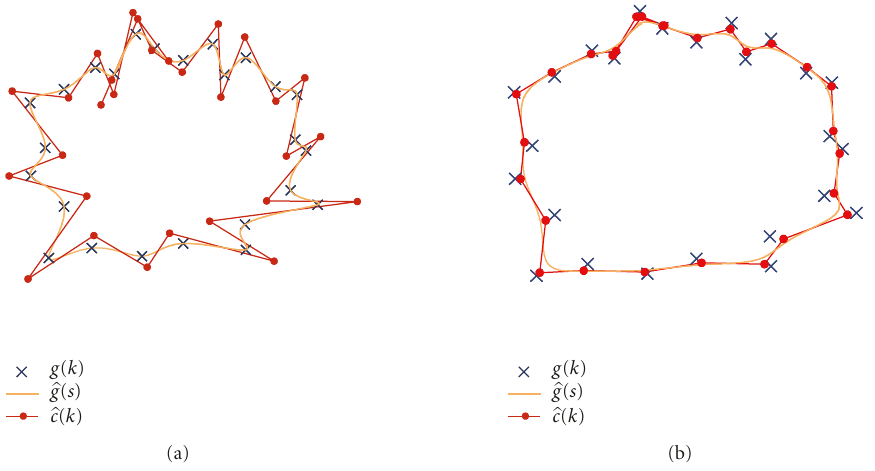
Figure 3: A smoothing B-spline curve. The points to approximate are the g ( k ) represented by the cross symbols. The (cid:9) c ( k ) are the coe ffi cients of the smoothing B-spline and are represented by the dot symbols. The curve (cid:9) g ( s ) is the approximating curve according to λ . (a) Approxi- mation of a point set g ( k ) with λ = 0. Note that in this case, we obtain a B-spline interpolation. (b) Approximation of the same point set with λ = 0 . 1.